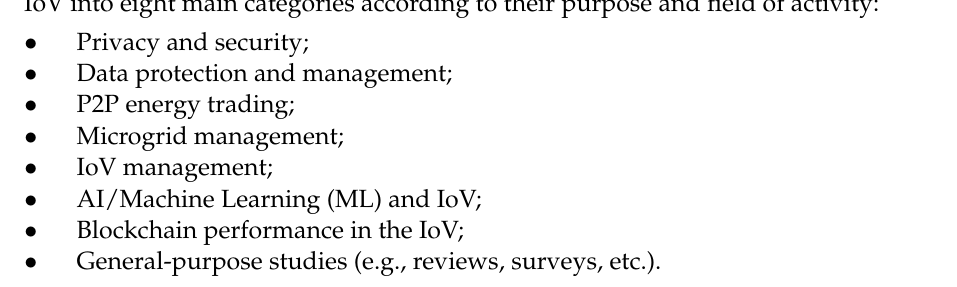
Figure 5. Distribution of studies from 2017 to 2021. During the analysis process, the authors classified blockchain applications within the IoV into eight main categories according to their purpose and field of activity: •